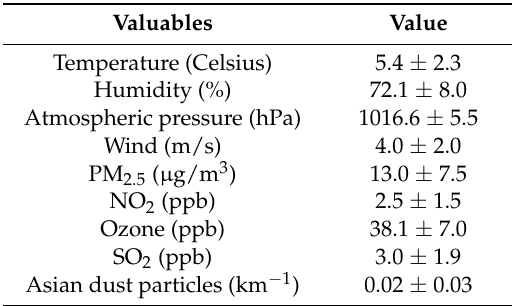
Table 2. Average meteorological and air contaminant levels from 1 to 28 February